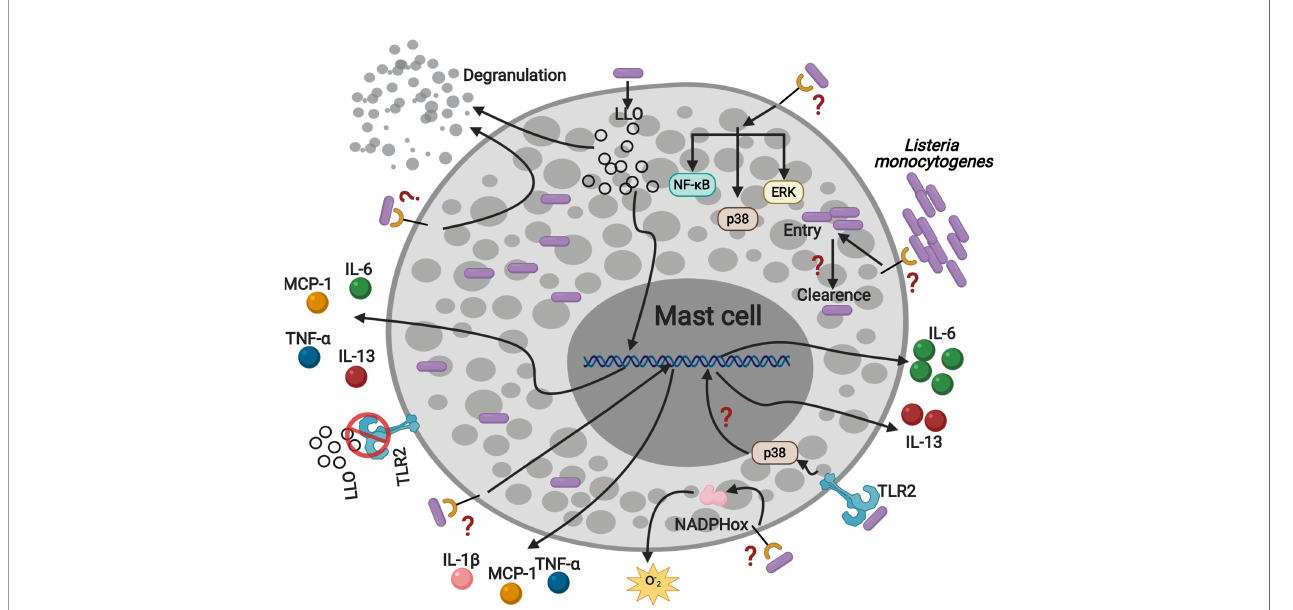
FIGURE 8 | Listeria monocytogenes activates mast cell through TLR2 inducing p38 activation, IL-6 and IL-13 production. MC are infected by L.m and they can eliminate the intracellular bacterial load. In addition, L.m infection activates several signaling proteins: ERK, p38 and NF- k B, which could drive MC to degranulate, ROS and cytokines production. Furthermore, the recognition of L.m by TLR2 promotes p38 activation and the production of IL-6 and IL-13. In addition, LLO induced the production of TNF- a , IL-6, IL-13 and MCP-1 independently of TLR2, indicating that other mechanisms or mast cell receptors are regulating the interaction with L.m. This fi gure was created with